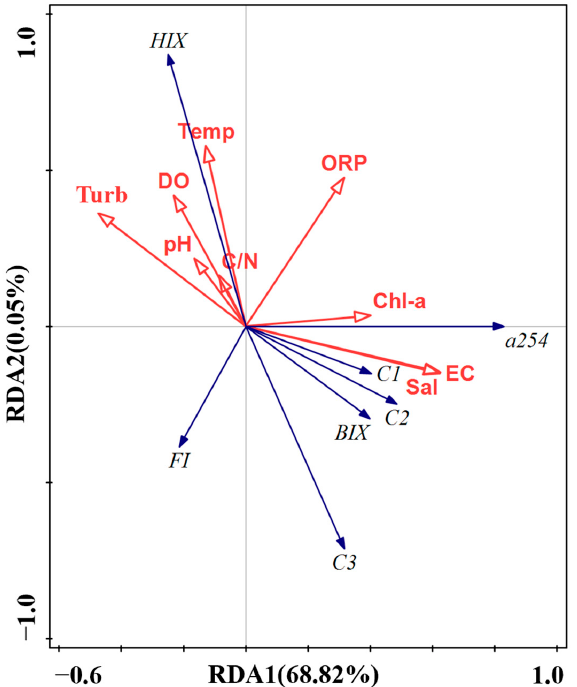
Figure 7. RDA of spectral parameters and biogeochemical factors.